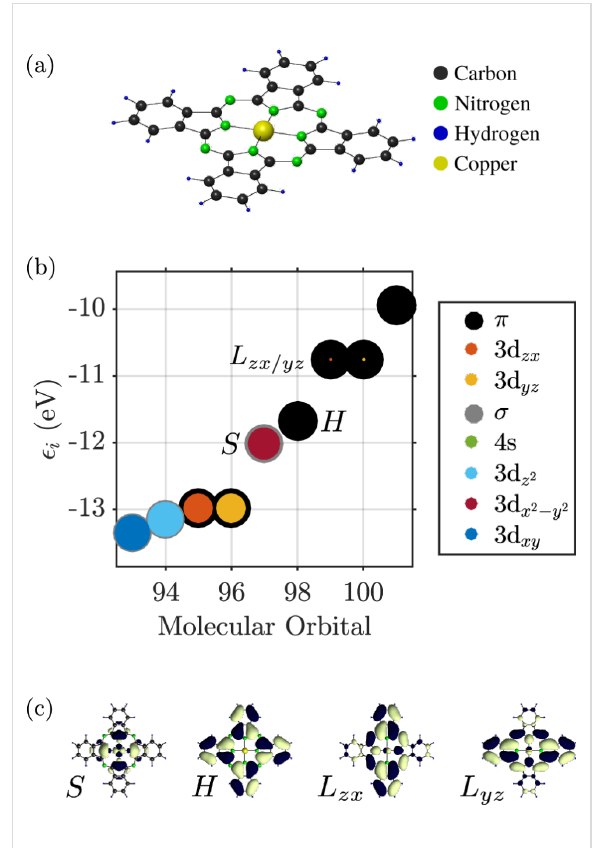
Figure 1: (a) Geometry and atomic composition of CuPc. (b) Single particle energies of relevant molecular orbitals. Black (grey) circles depict the π ( σ ) character of the corresponding orbital. The color (diameter) of the inner circles characterizes the type (weight) of the metal orbital contribution on the corresponding molecular orbital. (c) Depiction of the four frontier orbitals retained in this work: SOMO ( S ), HOMO ( H ) and LUMO zx/yz ( L zx/yz